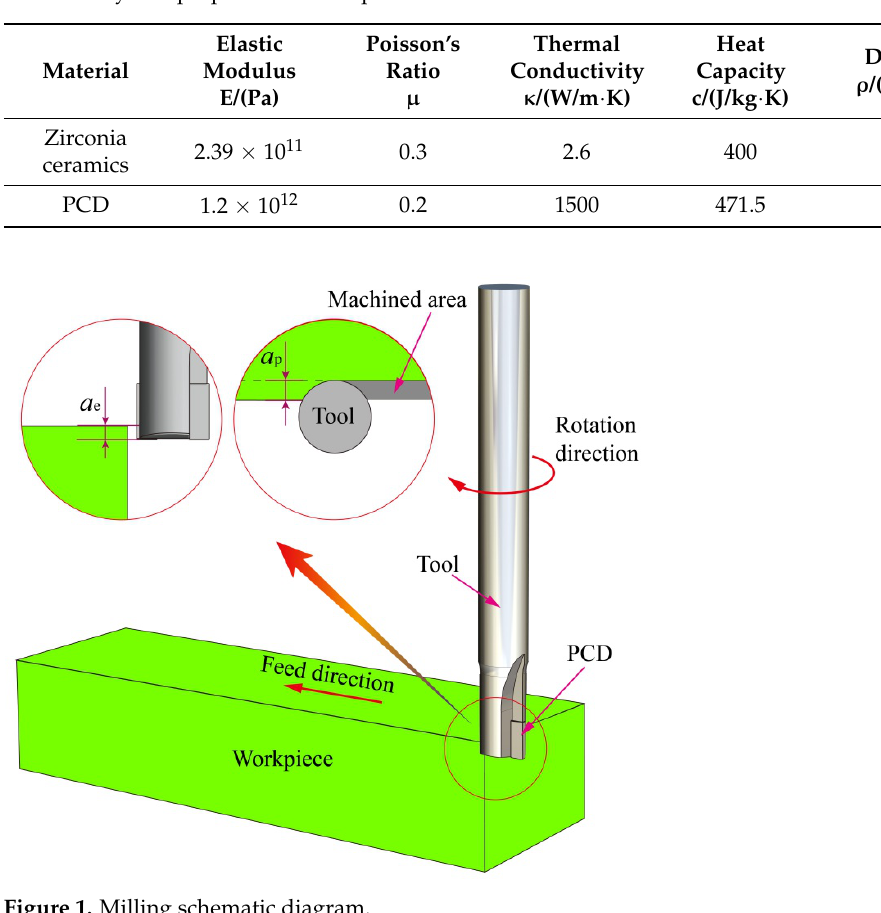
Figure 1. Milling schematic